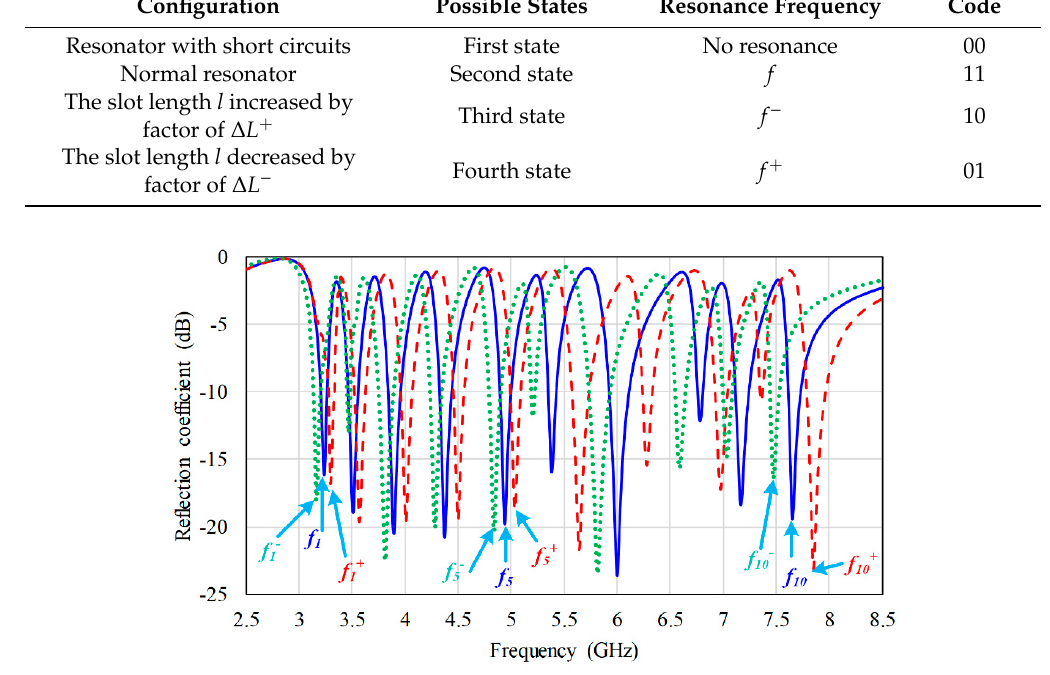
Table 4. Possible states for a single resonator.